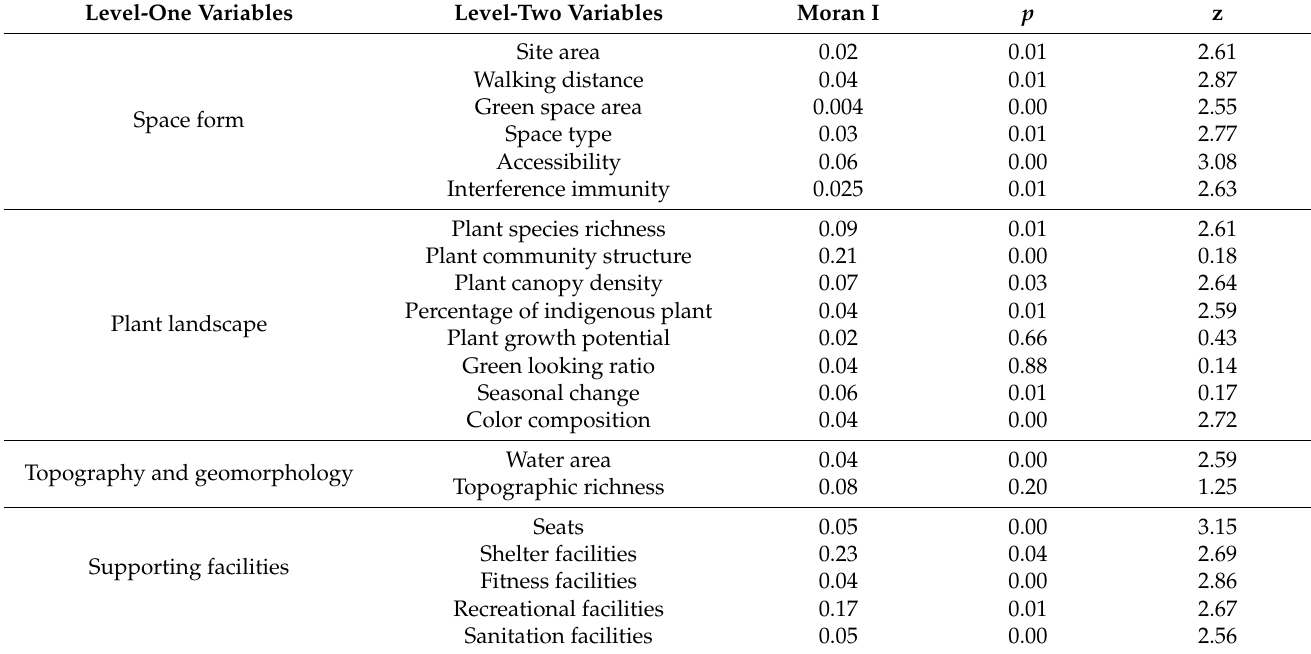
Table 2. Moran’s Index for Environmental Factors.